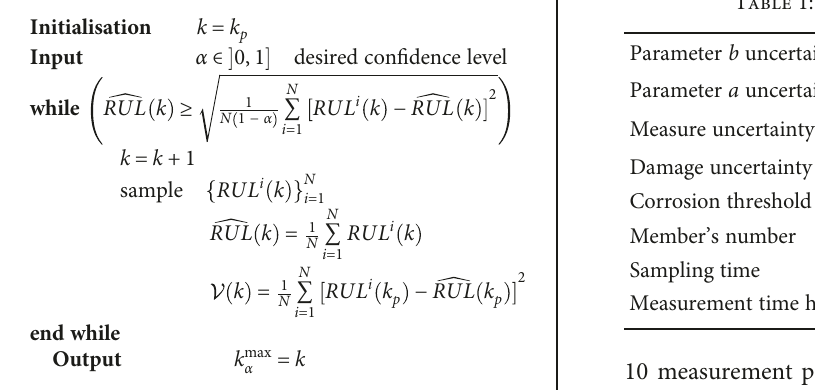
Table 1: Constants and simulation